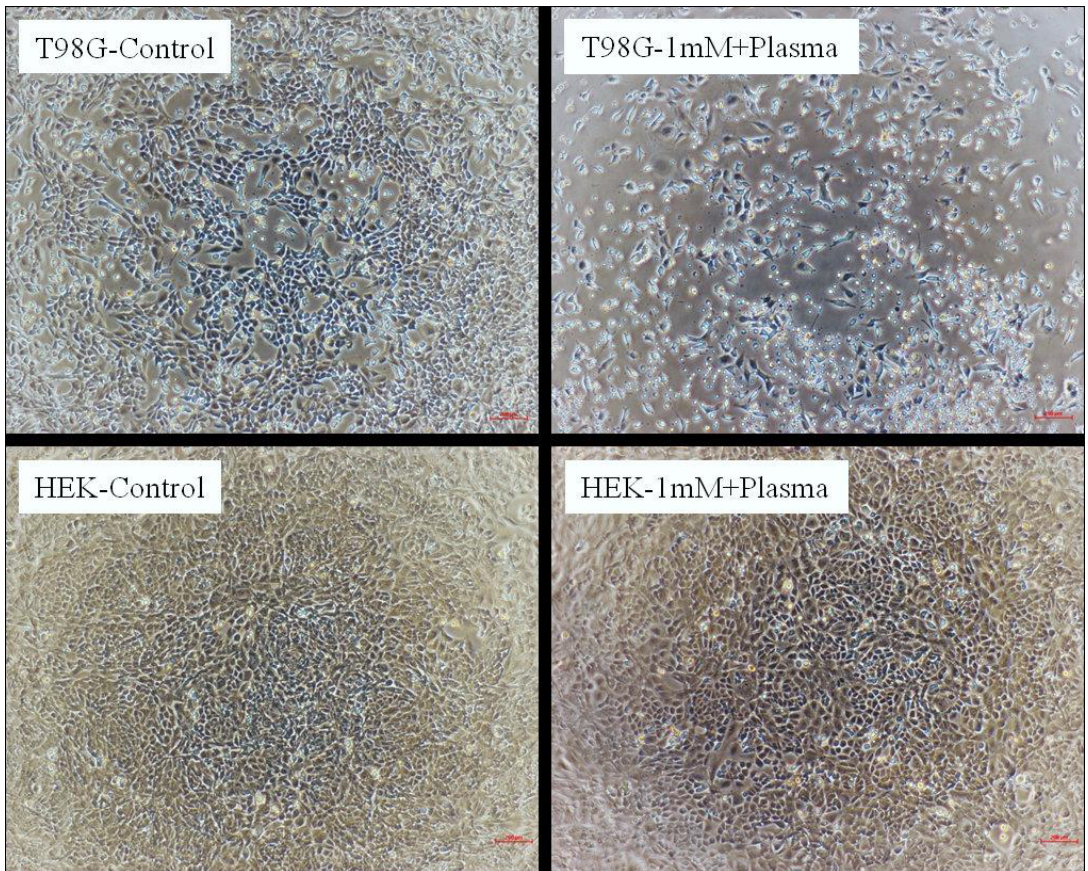
Figure 7. Morphology of T98G and HEK non-malignant cells after 72 h of treatment at 1 mM concentrations of sucrose with plasma (240 s). Control is untreated control cells. Images are taken by NIKON eclipse T i inverted microscope.